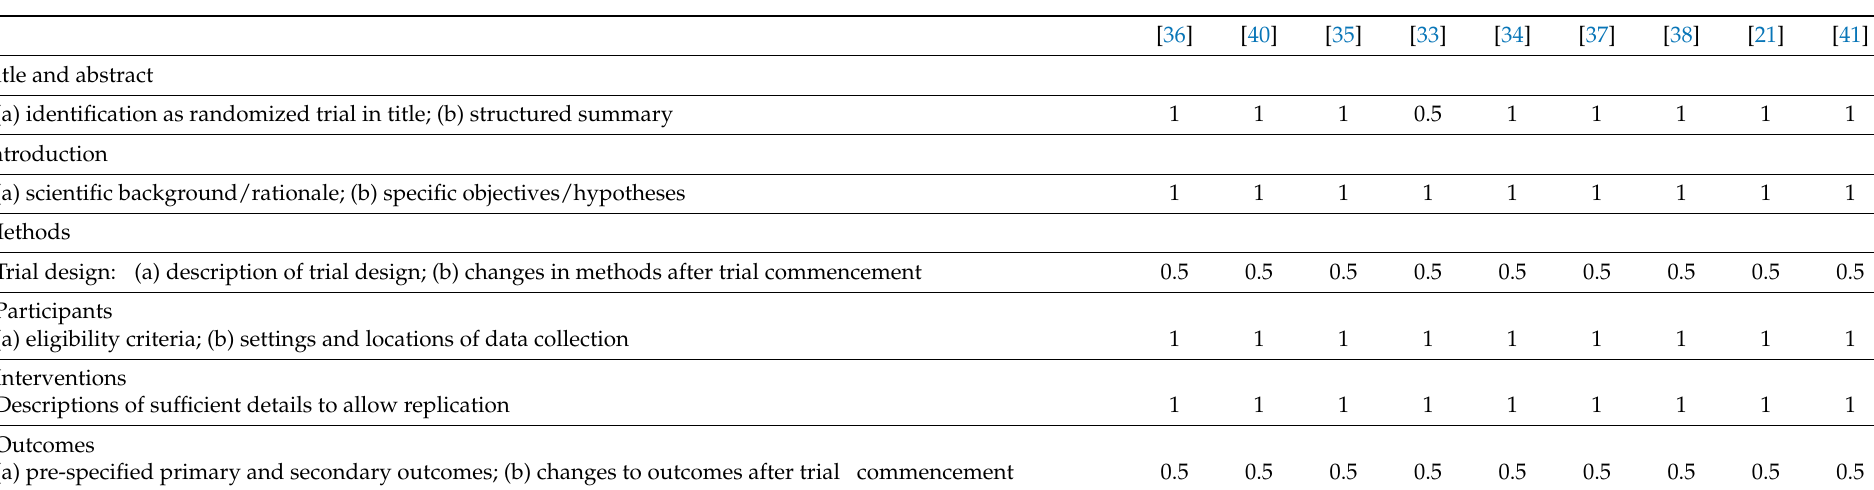
Table A2. Synthesis of quality assessment of included RCTs ( n =